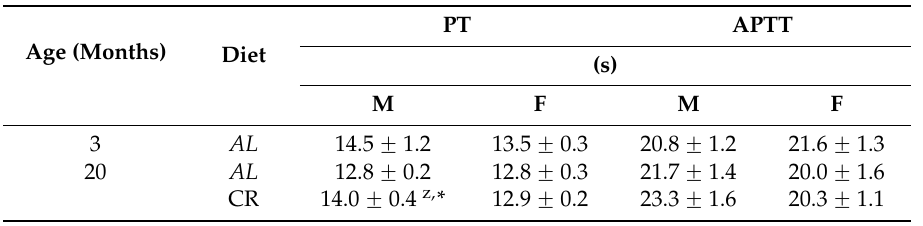
Table 5. Prothrombin (PT) and activated partial thromboplastin (APTT) times of 3- and 20-month-old M and F Sprague–Dawley rats fed an AL or CR